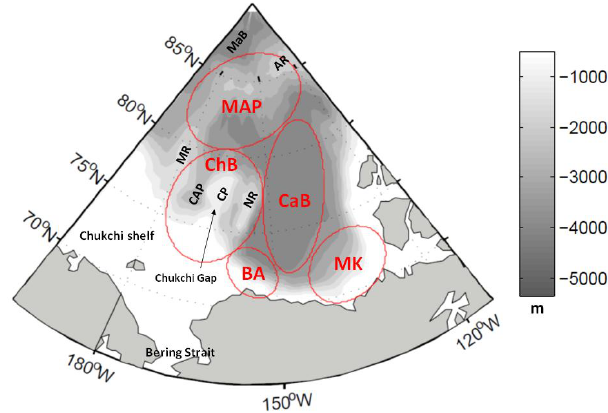
Figure 2: Bathymetry and main topographic features of the Canadian Basin. CP stands for Chukchi Plateau, NR for Northwind Ridge, and CAP for Chukchi Abyssal Plain. AR and MR stand for Alpha Ridge and Mendeleyev Ridge respectively, and MaB stands for the Makarov basin. The ellipses correspond to the five subdivisions of the area chosen for this study: the Chukchi borderland (ChB including the CP, the NR and the CAP), the Barrow canyon region (BA), the Mackenzie River region (MK), the Canada basin (CaB), the Mendeleyev Abyssal Plain (MAP).